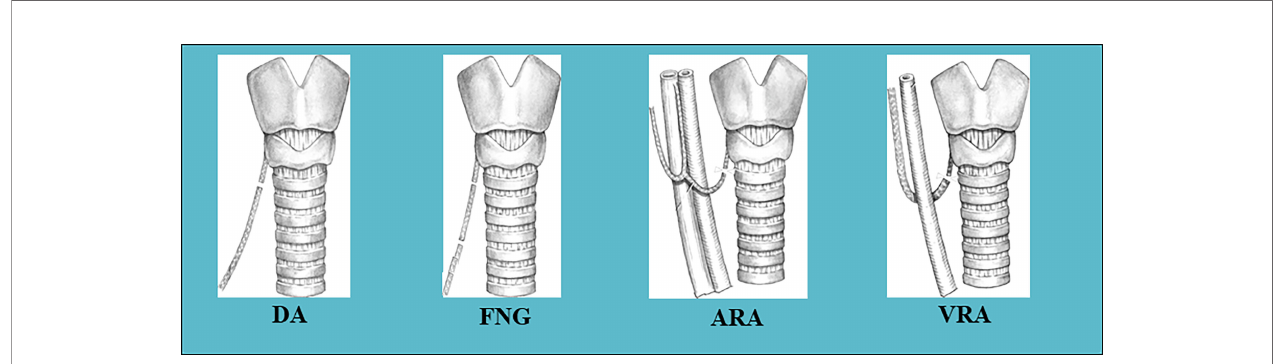
FIGURE 3 | Methods of reconstruction of the RLN used in this series: DA, direct anastomosis; FNG, free nerve grafting; ARA, ansa cervicalis-RLN anastomosis; VRA, vagus-RLN anastomosis.